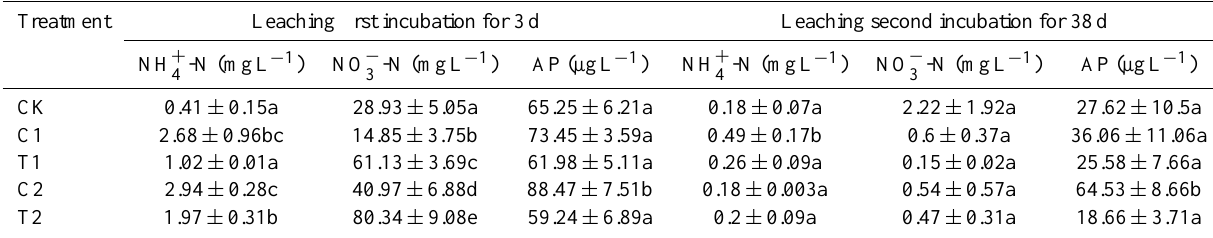
Table 2. Change of inorganic N and available P in leaching solution. CK (control); C1 (soil added with 2.5% biochar); T 1 (soil added with 2.5% furfural); C2 (soil added with 5% biochar); T 2 (soil added with 5% furfural). Treatment Leaching first incubation for 3d Leaching second incubation for